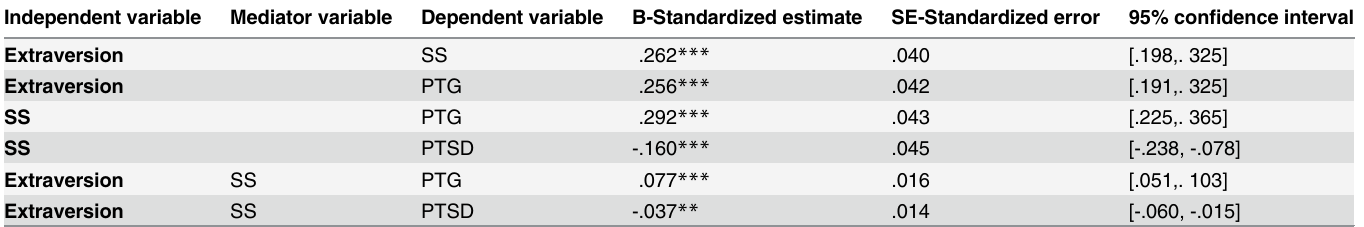
Table 3. Bootstrap analysis of the magnitude of the effects in the final